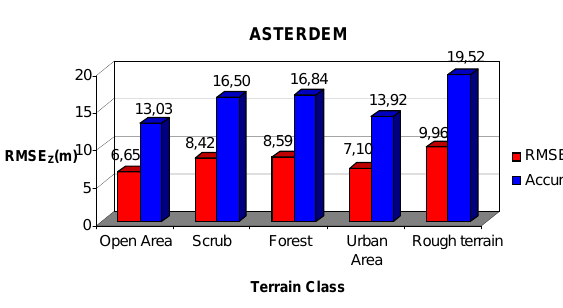
Figure 6. ASTERDEM analyses according to the classes